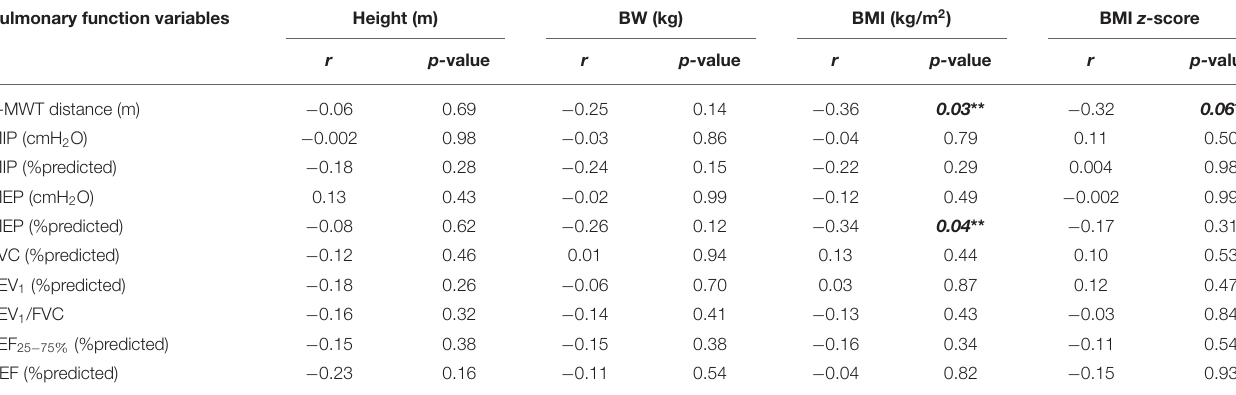
TABLE 3 | Correlation between obesity indices (weight, BMI, and BMI z -score) and 6-MWT distance, RMS, and spirometry in the obesity group. Pulmonary function